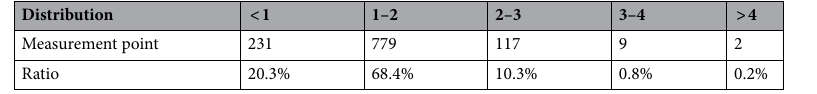
Table 1. Ratios of the measured maximum horizontal principal stress to the vertical stress in China.